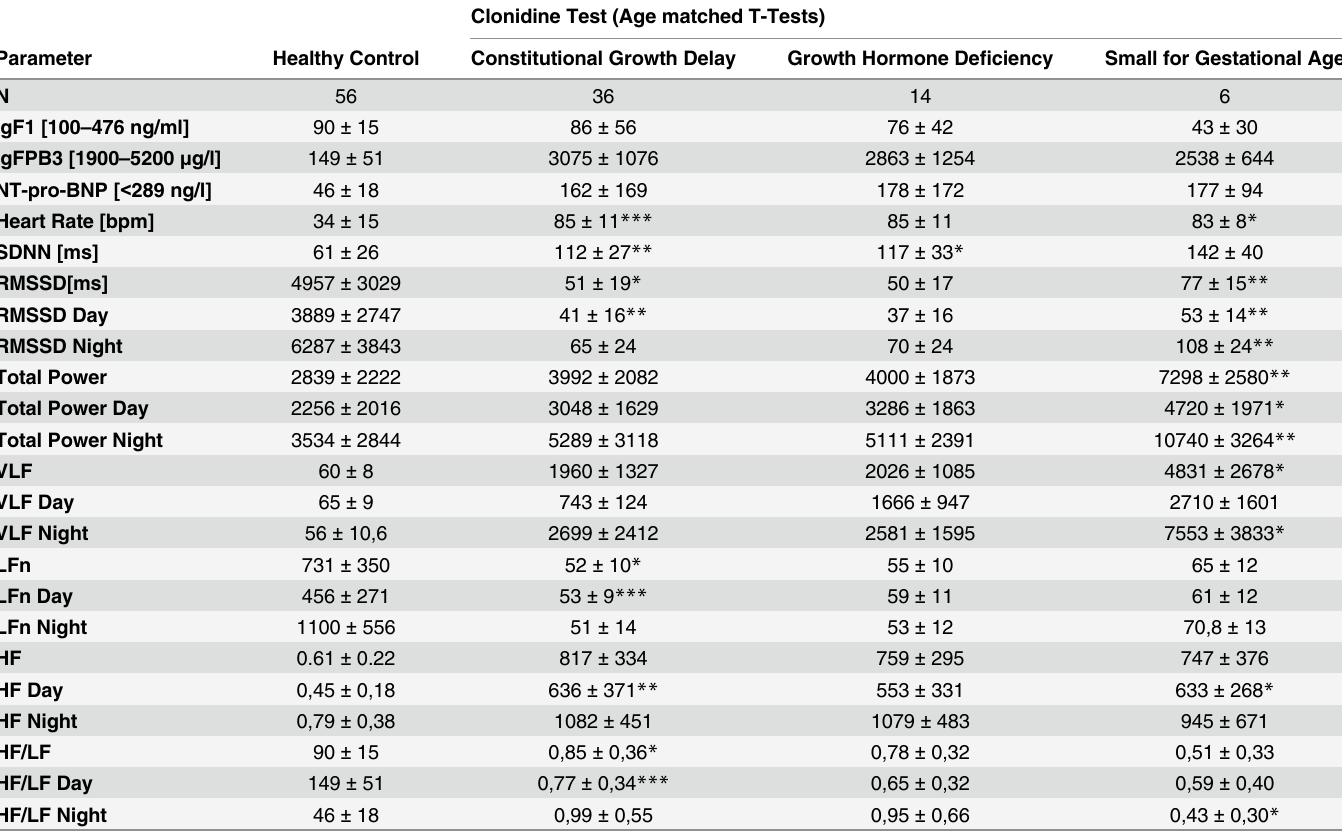
Table 2. Growth factors and HRV data of healthy controls and children with CGD, GHD and SGA. Clonidine Test (Age matched